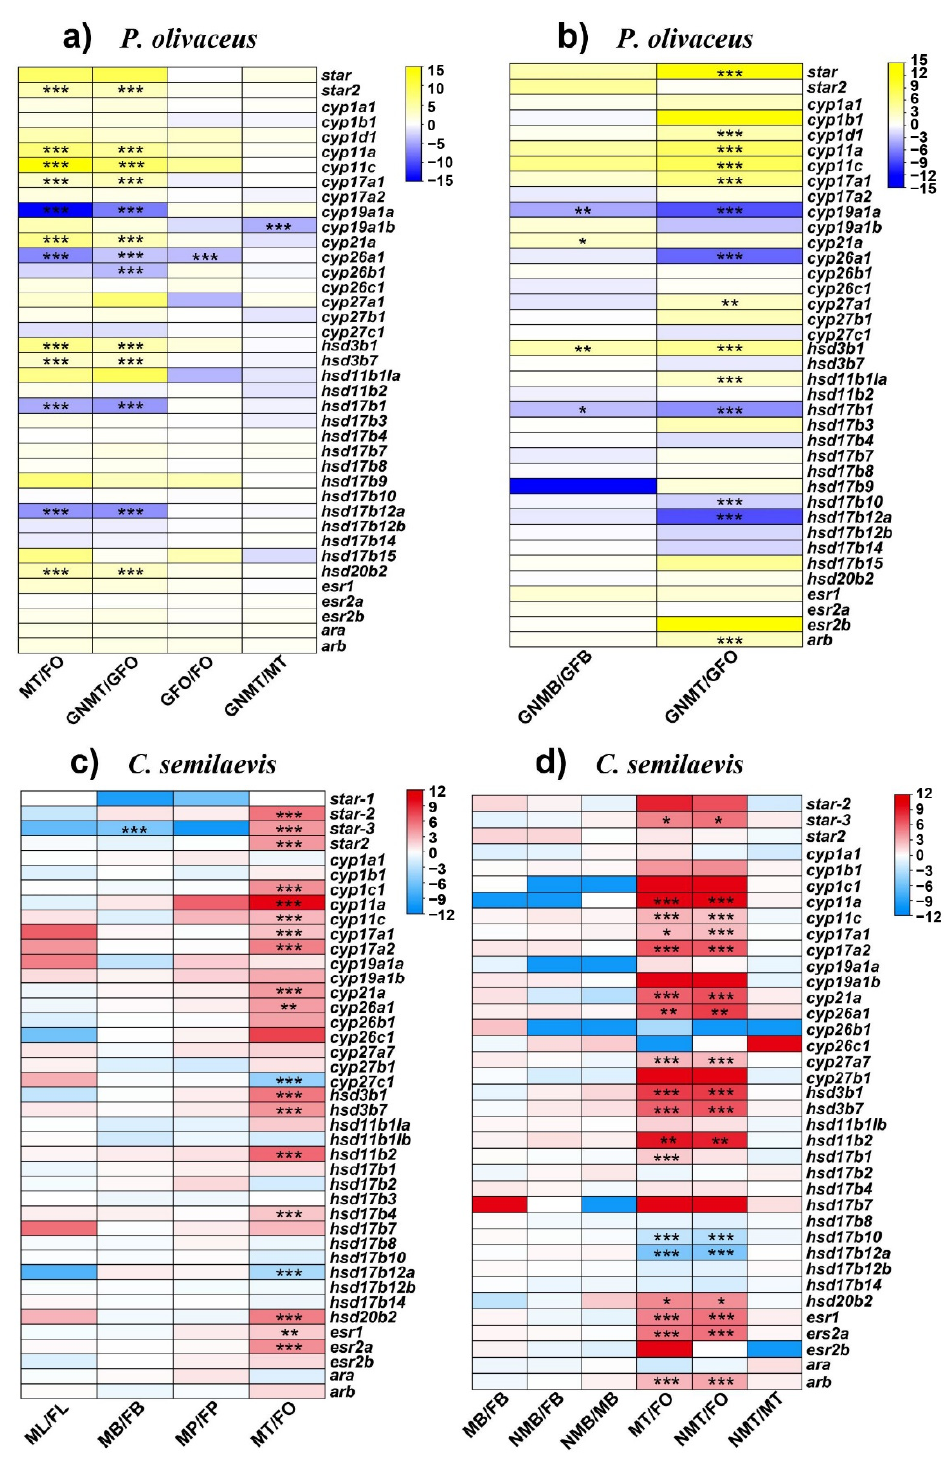
Figure 5. Differential expression of steroidogenic genes in P. olivaceus and C. semilaevis , as ( a ) wildtype female ovary (FO) vs. wildtype male testis (MT) and gynogenetic female ovary (GFO) vs. gynogenetic neo-male testis (GNMT) of P. olivaceus ; ( b ) brain (B) and gonad (O/T) of gynogenetic P. olivaceus ; ( c ) four HPG/L axis tissues of male and female C. semilaevis , as L-liver, B-brain, P-pituitary, O/T-ovary/testis; ( d ) brain (B) and gonad (O/T) of female, male and neo-male C. semilaevis . The Heatmaps were represented with the log 2 (FC) values of each gene. * indicates p < 0.05, ** indicate p < 0.01, *** indicate p < 0.001.